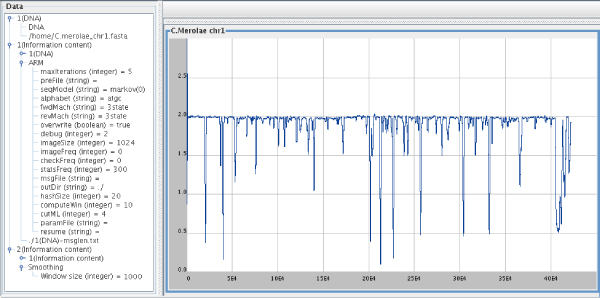
Plot for C. merolae chromosome 1, smoothing window 1000. Information sequence from ARM for C. merolae chromosome 1, with a smoothing window of 1000 bp.